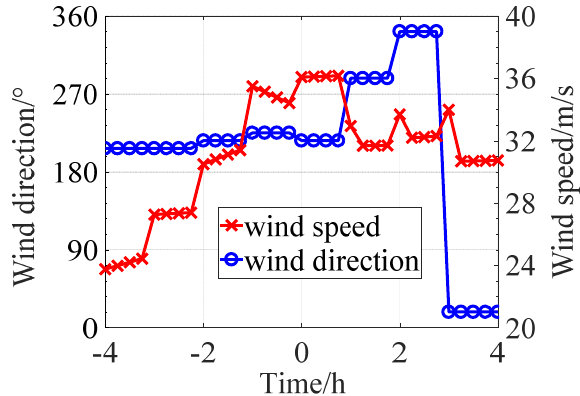
Figure 6. The real-time average wind speed.